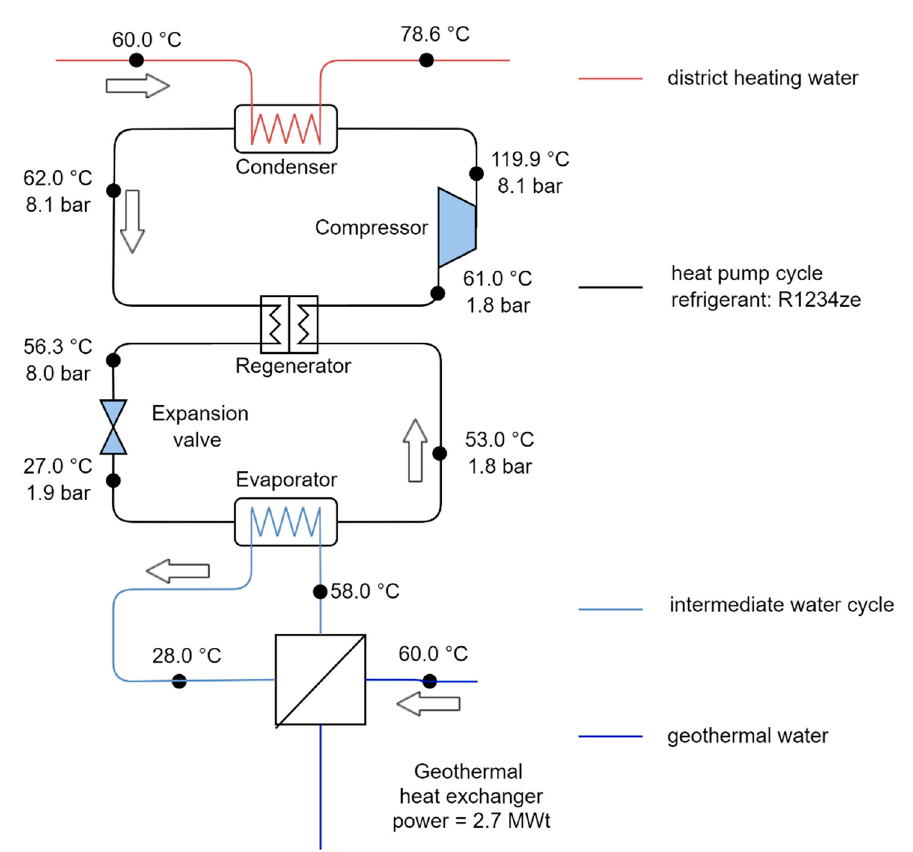
Figure 8. Scheme of the regenerator variant.